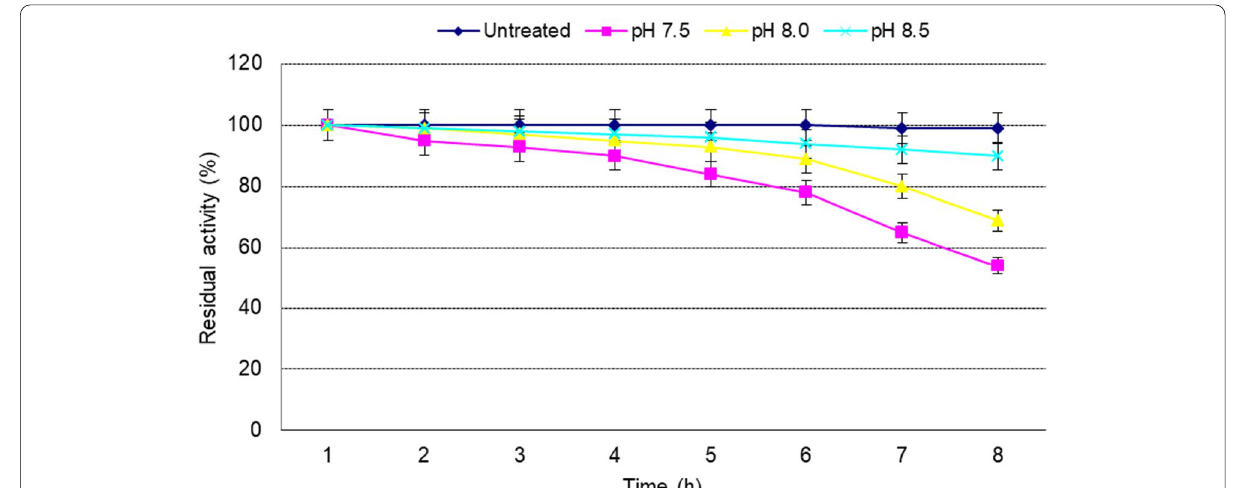
Fig. 9 Monitoring of pH stability for recombinant cellSNSY enzyme activity through long‑term preservation at